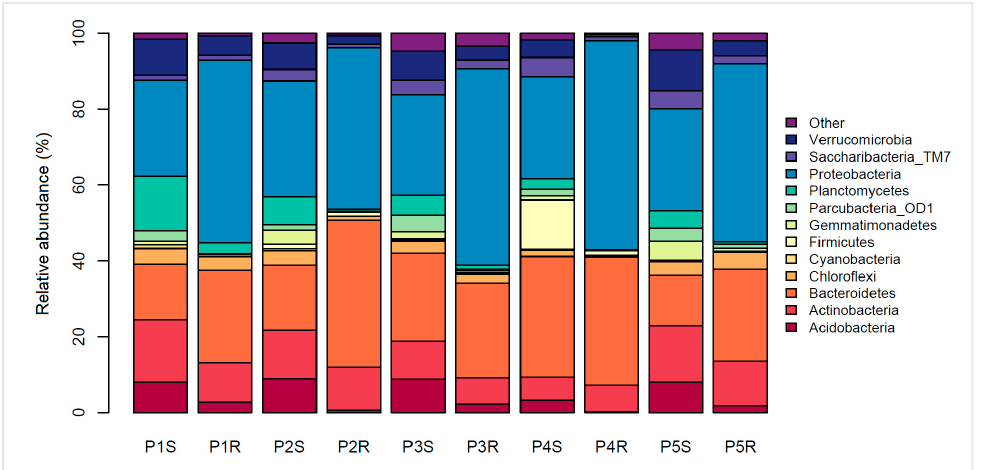
Figure 2. Relative abundance by percentile contribution of sequences identified on a phylum-rank taxonomic level. Other—group of bacterial phyla below 1% relative abundance each, S—rhizo- spheric soil samples, R—root samples, P1–P2—Central European (Poland) samples, P3–P5—Ant- arctic samples (King George Island).